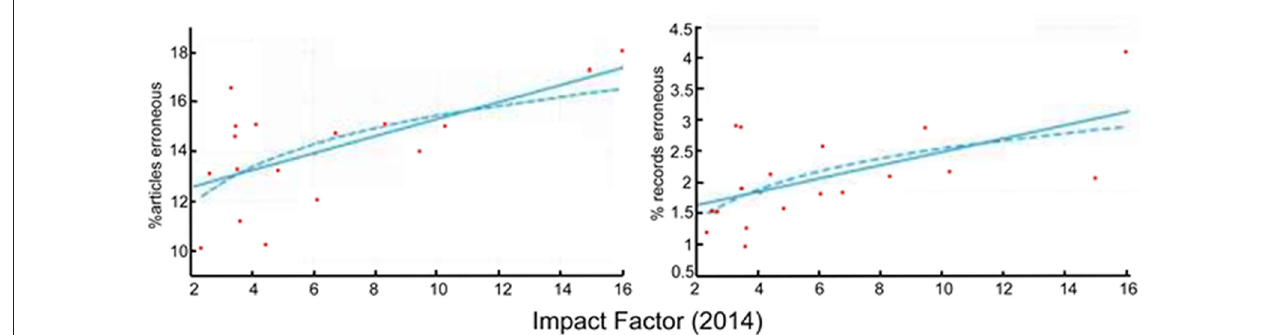
FIGURE 6 | p -value reporting errors correlate significantly with journal rank. The correlation of the median percentage of articles with erroneous articles (left; which can contain multiple erroneous records) or individual records (right) in a given journal and journal IFs. Both linear and logarithmic (log[journal IF]) trend lines are shown. Figure redrawn from Szucs and Ioannidis